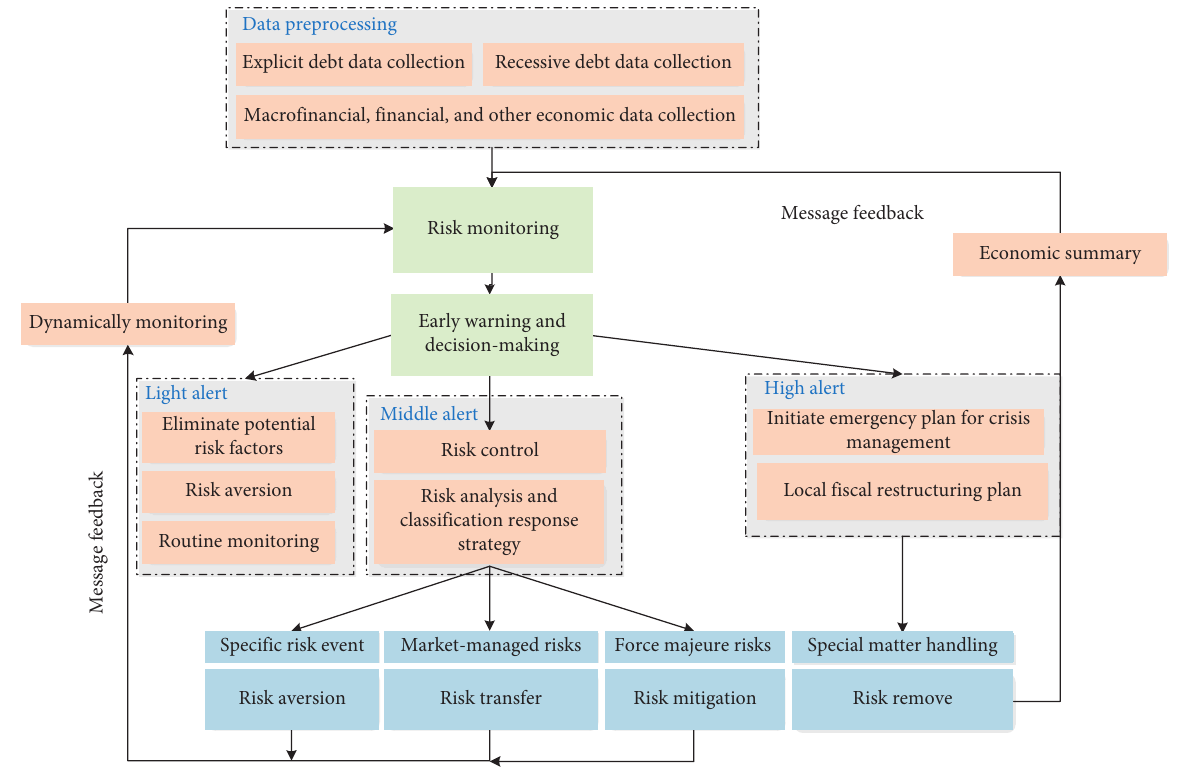
Figure 1: The basic framework of the government debt risk assessment system.